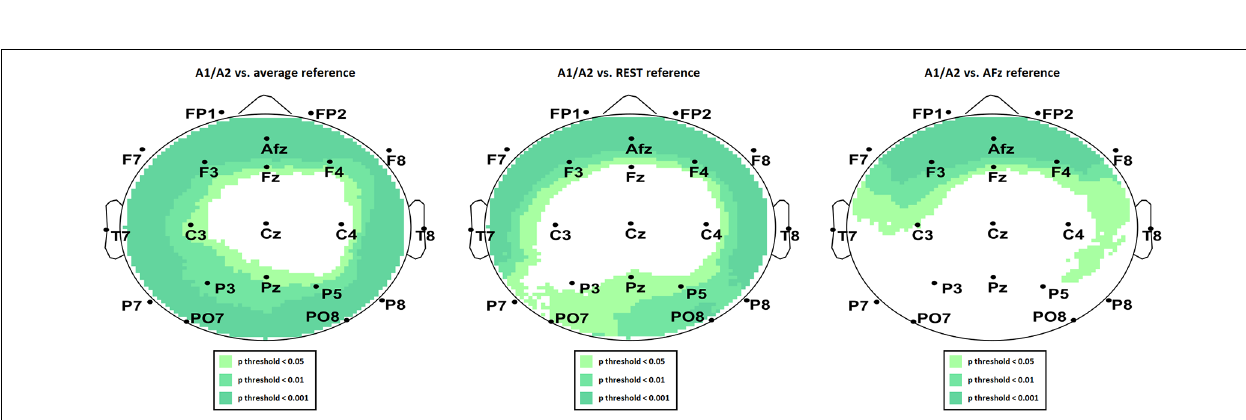
FIGURE 9 | Statistical comparison of average component activation between A1/A2 as the reference site and average (left), REST (middle), and AFz (right) as referencing